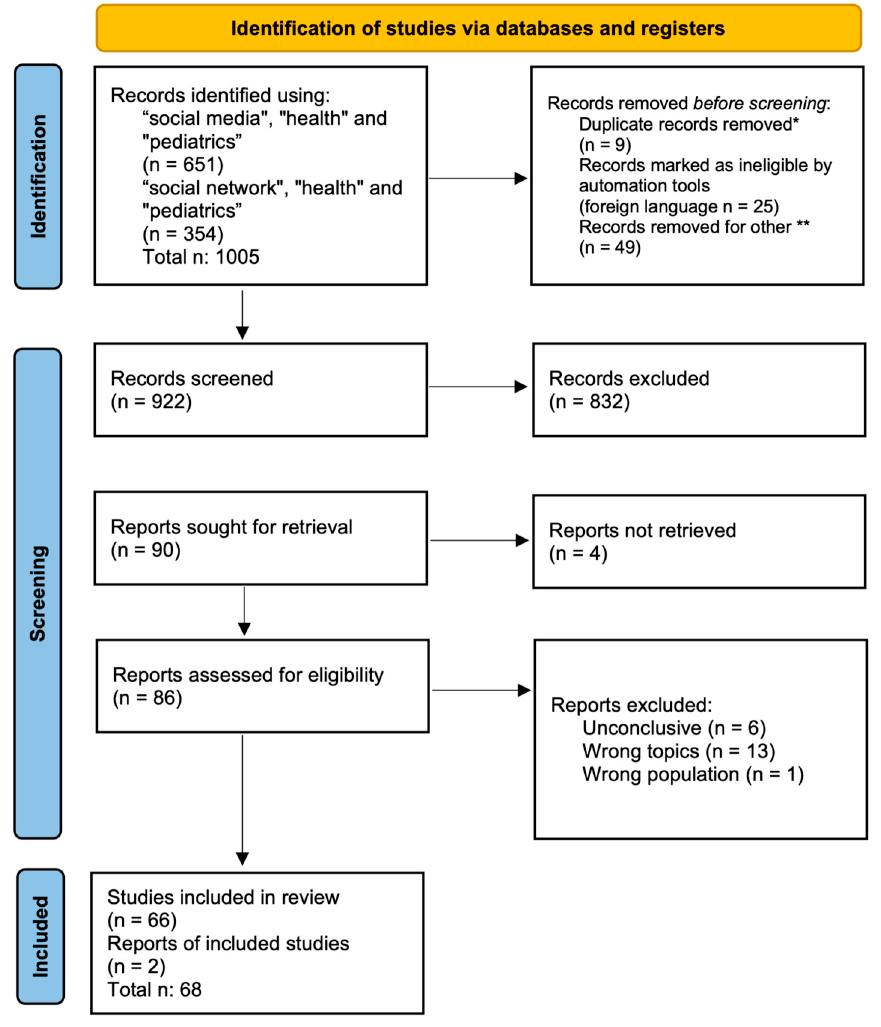
Figure 1. Flow chart of the selection process. * automation tools were used: 6 records were excluded by automation tools and 3 were excluded by authors. Twenty-five records were excluded because they were not written in English, these were identified using automation tools, but then checked by authors. ** 49 records were removed because they were published before 2004, and no social network existed before that year.